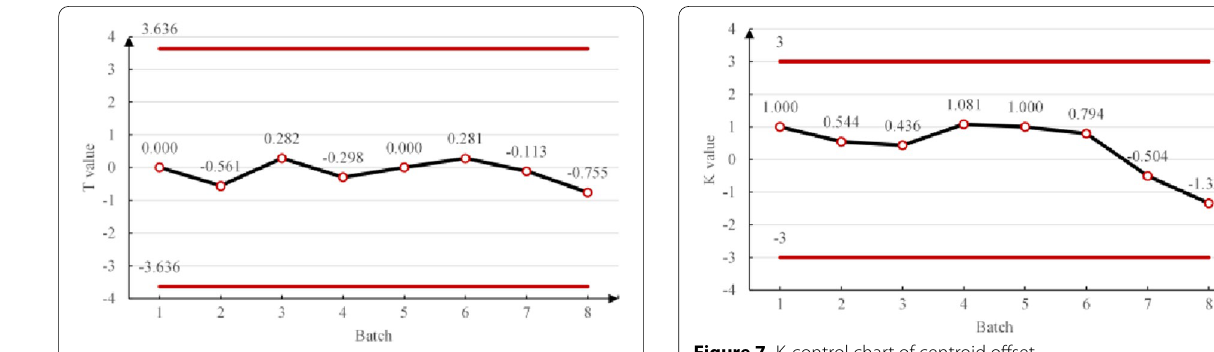
Figure 6 T-control chart of centroid offset of cabin A Figure 7 K-control chart of centroid